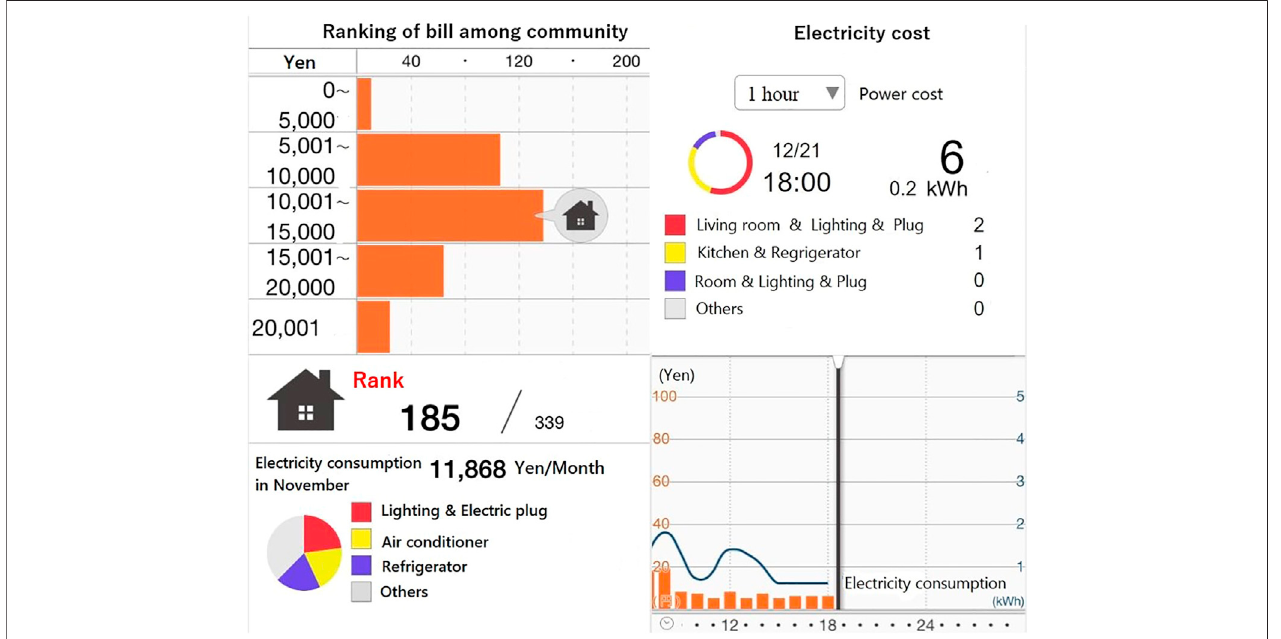
FIGURE4| HEMSinterface and availableonlineinformation: viewoftheir cost level among thecommunityand detailed real-time electricityconsumption and cost.